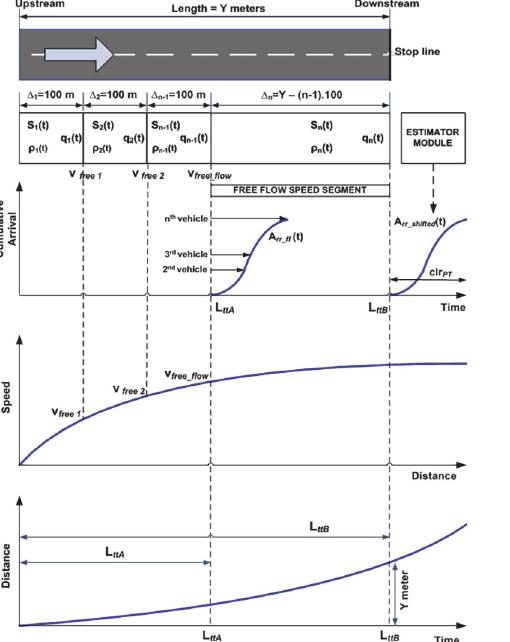
Fig 3. Integrated model